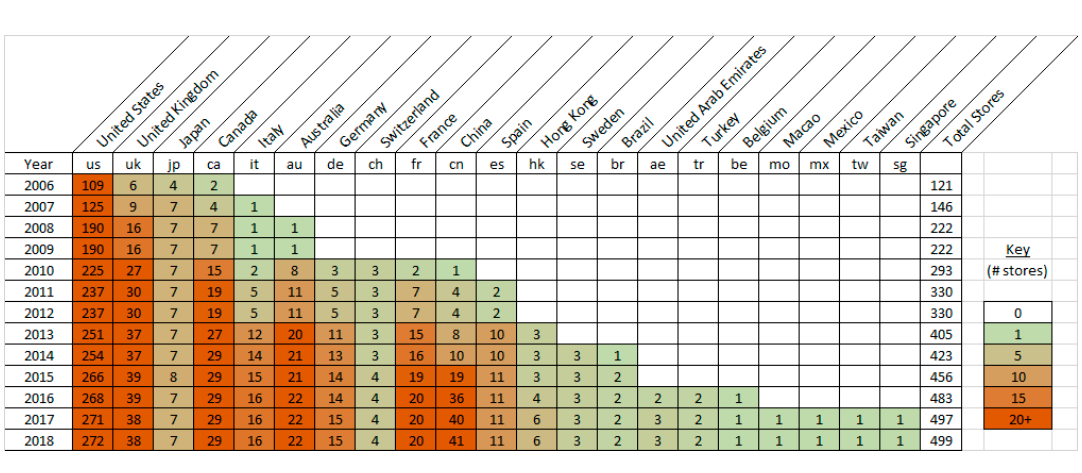
Figure 11. Store location capture experimental architecture.